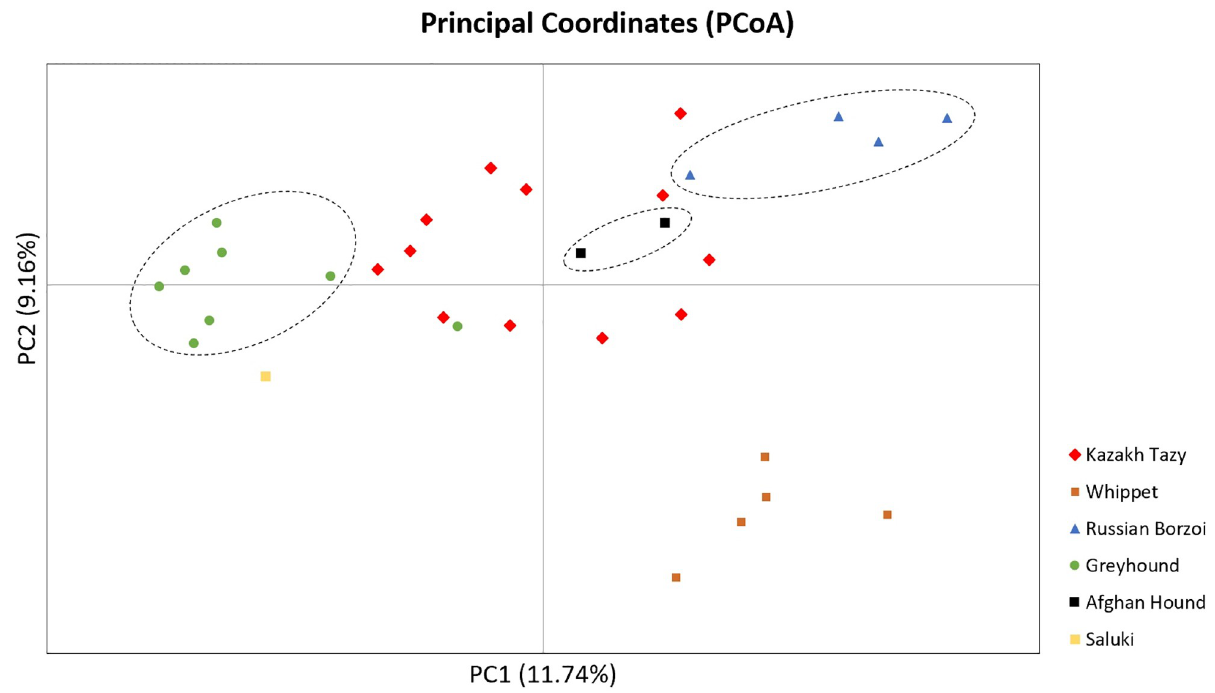
Fig 4. PCoA plot showing population structure of sighthound breeds based on the STR